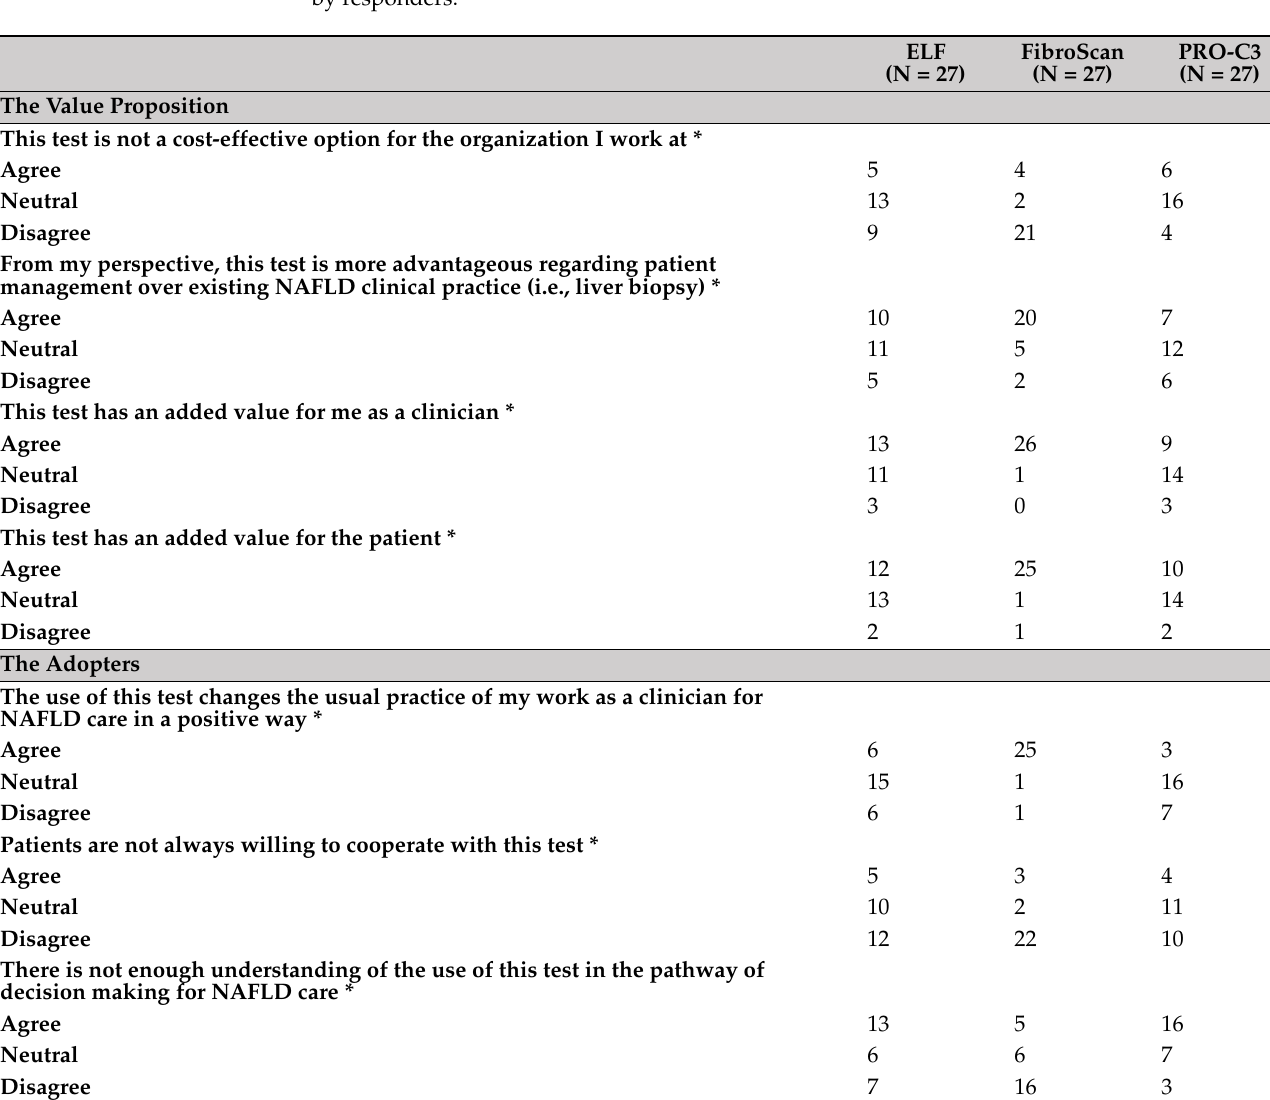
Table 4. Results per items of “The Value Proposition” and “The Adopters” domains of the Non- adoption, Abandonment, Scale-up, Spread, and Sustainability (NASSS) framework as reported by responders.